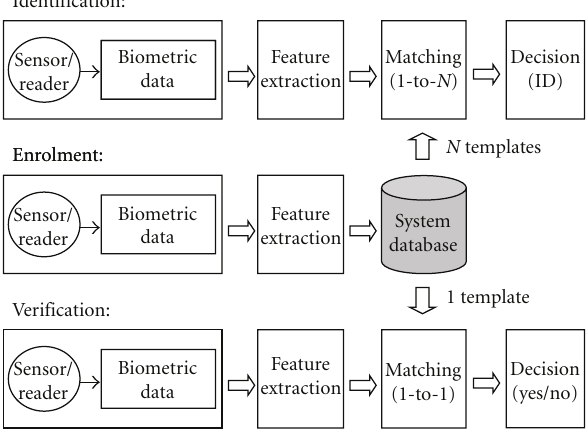
Figure 1: Block diagram of biometric recognition